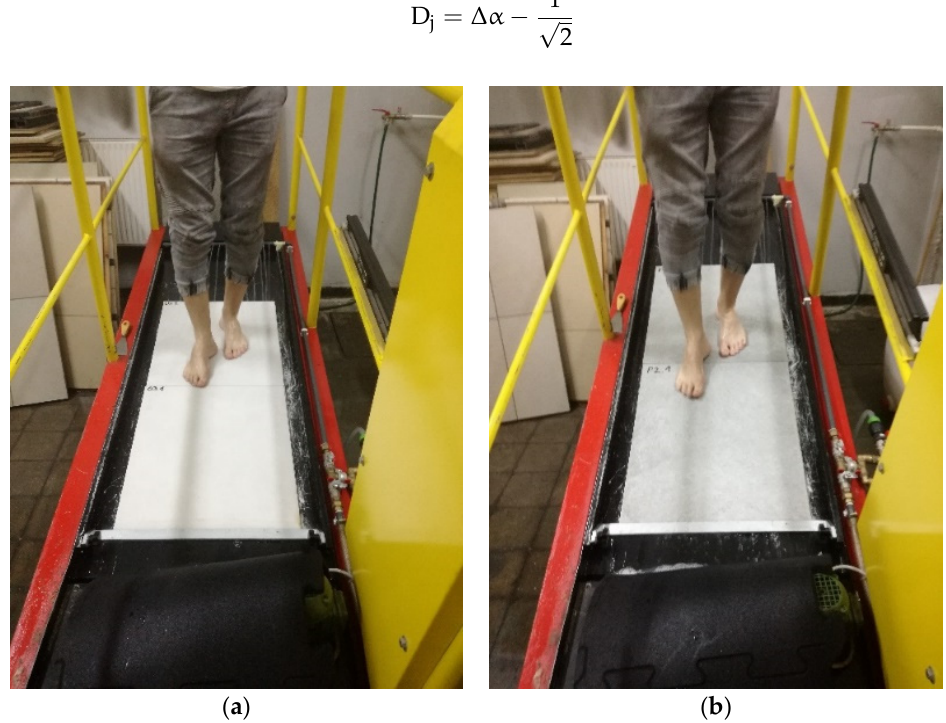
Figure 3. The acceptable angle (ramp) barefoot test on ( a ) S5 and ( b ) S4 samples in wet conditions.